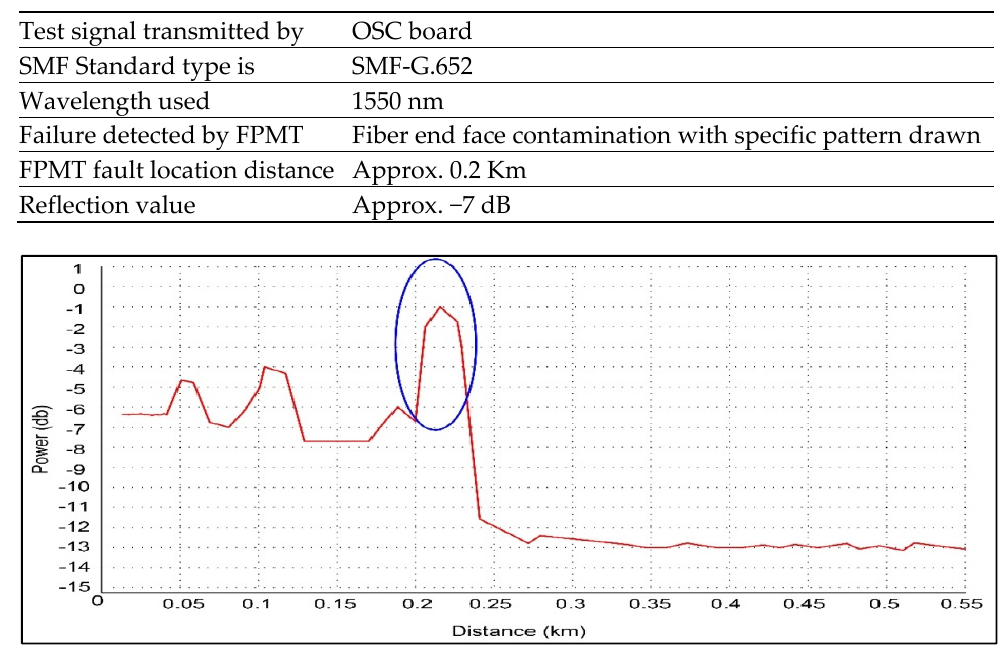
Figure 10. Event is Fiber end face contamination (standard SMF G.652 at 1550 nm was used and FPMT test signal was transmitted by the OSC board).